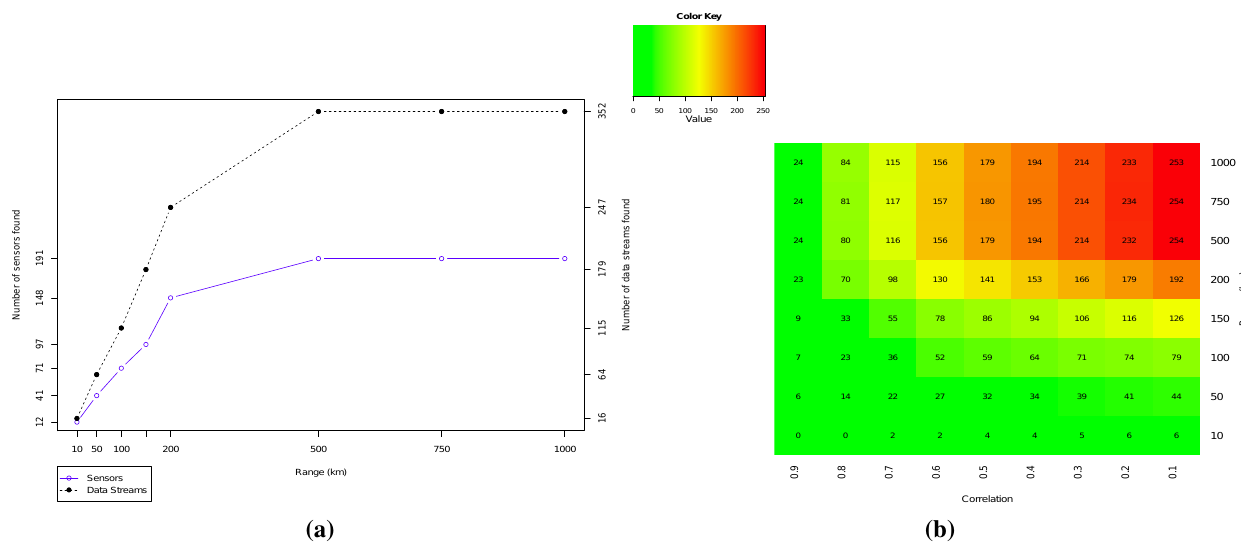
Figure 7. Analysis of the number of sensors found in Dataset 1. ( a ) Number of sensors and their data streams found for different sensor search ranges (Dataset 1); ( b ) Heat map for the number of data streams found when varying the range of the desired location area and the correlation coefficient limit (Dataset